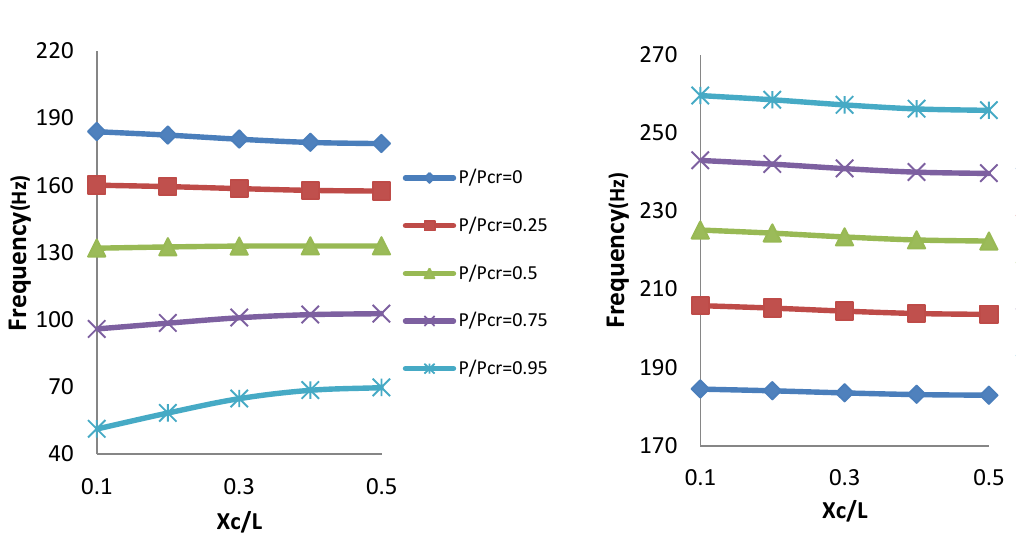
Fig. 2. First frequency of cracked beam, subject to compressive load